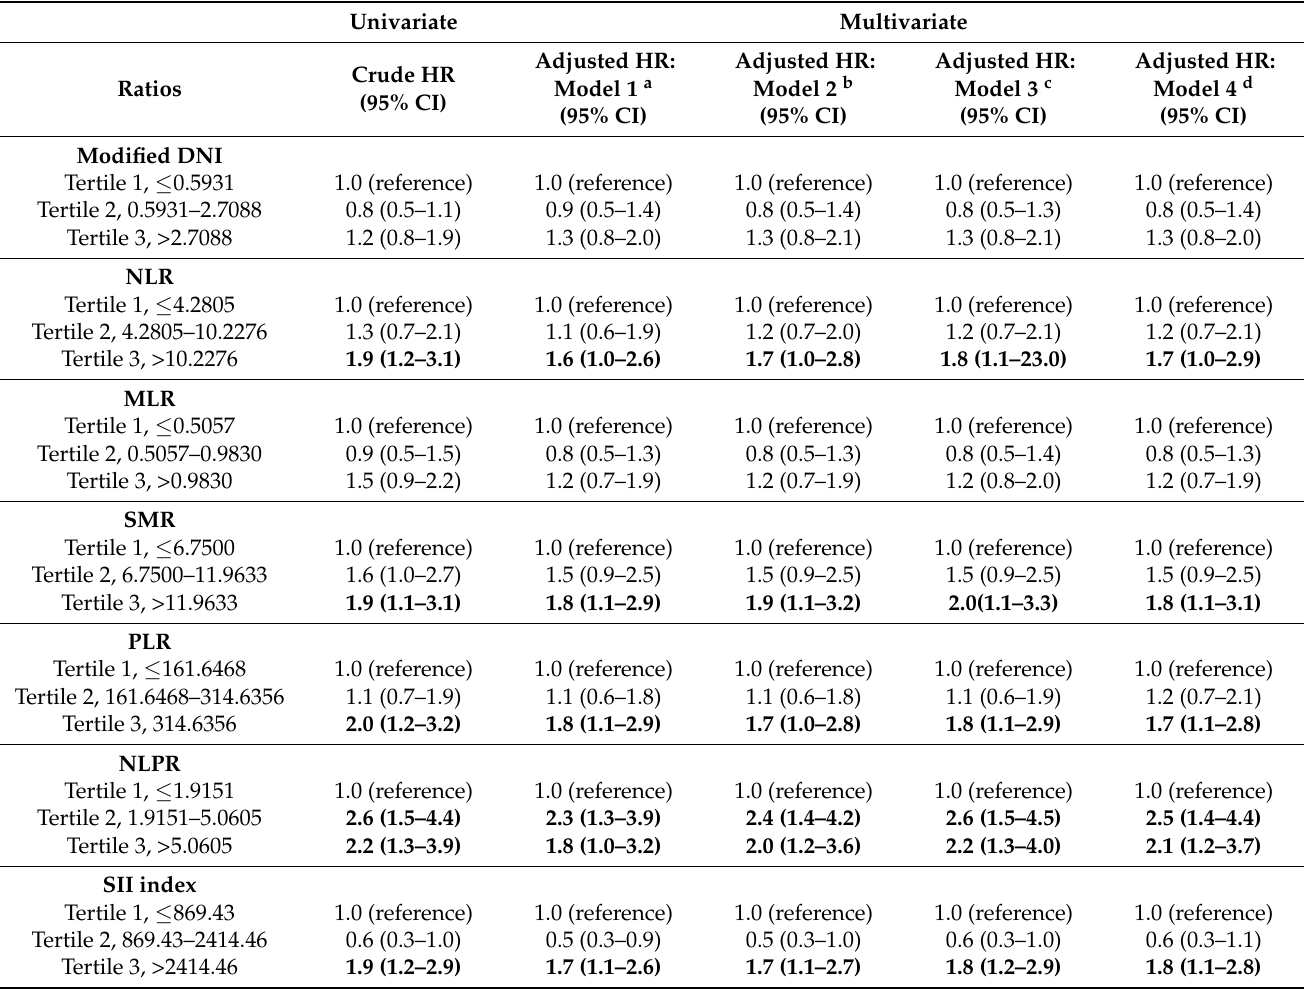
Table 4. HR’s (95% CIs) for 30-day all-cause